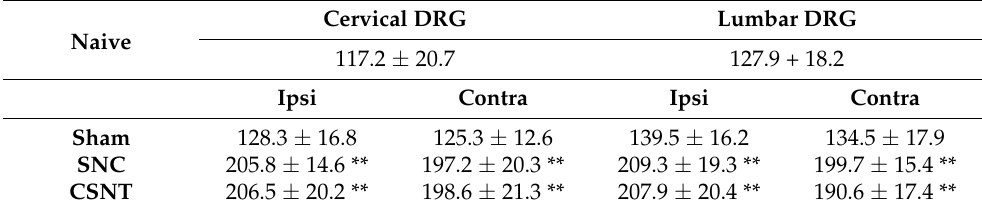
Table 1. Results from image analysis of TLR9 immunofluorescence intensity in the dorsal root ganglia (DRG) of cervical (C6-C8) and lumbar (L4-L5) spinal segments. The DRG were removed from naive rats (Naive) as well as those subjected to Sham, SNC and CSNT operation ( n = 6 for each group). The DRG of operated rats were removed from both ipsilateral (Ipsi) and contralateral (Contra) side to unilateral sciatic nerve lesions. The immunofluorescence intensity of TLR9 is expressed as mean ±